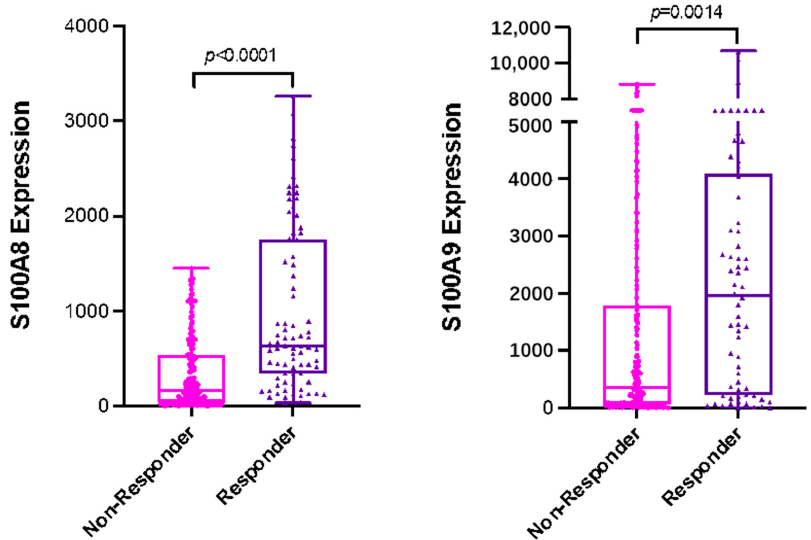
Figure 7. S100A8 and S100A9 are independent predictors of response to FEC therapy in breast cancer patients. S100A8 and S100A9 mRNA expression was compared between responders ( n = 84) versus non-responders (n = 219) to FEC treatment in a cohort of all breast cancer patients (S100A8: AUC = 0.71, p < 0.0001; S100A9: AUC = 0.626, p = 0.0014). Response defined as complete pathological response versus residual disease after completing therapy.